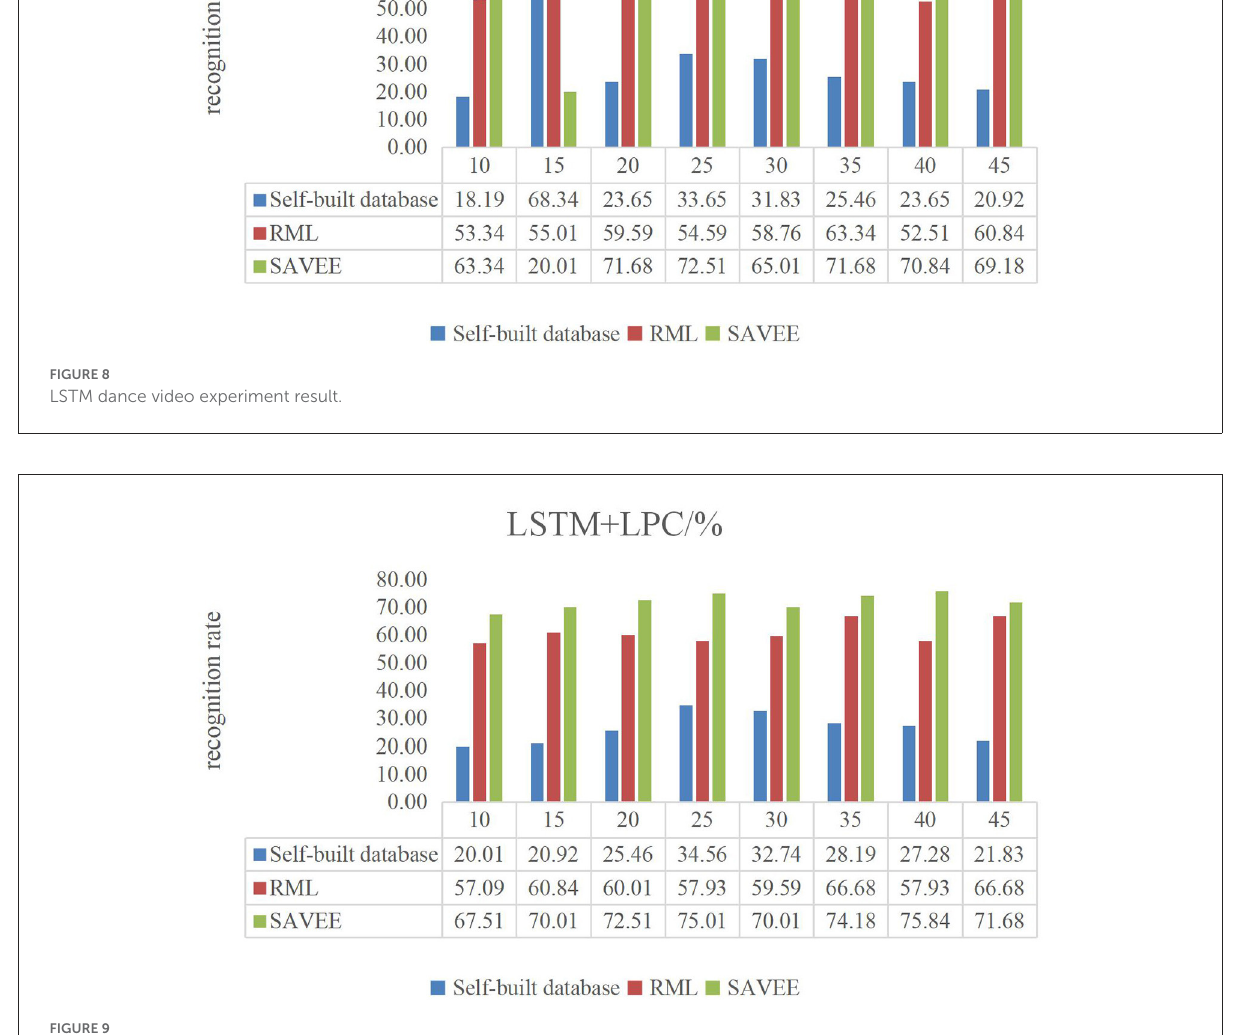
FIGURE9 LSTM + LPC dance video experiment